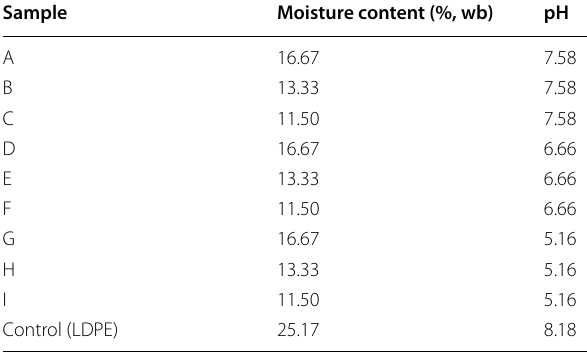
Table 2 A layout of the variables for microbial load investigation